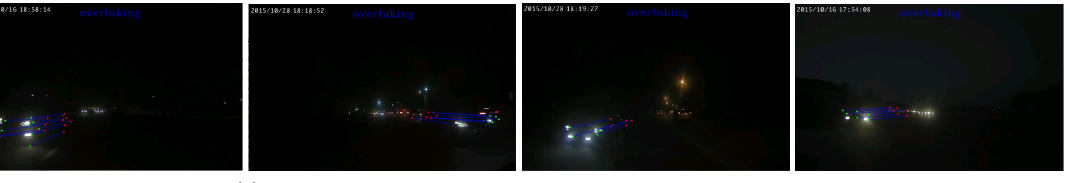
( c ) The overtaking detection results at night of city traffic scenes. Figure 15. The overtaking detection results for the city, highway, and night scenery. Table 3. The recognition results for each category and the recall. GT: ground-truth, BG: background,